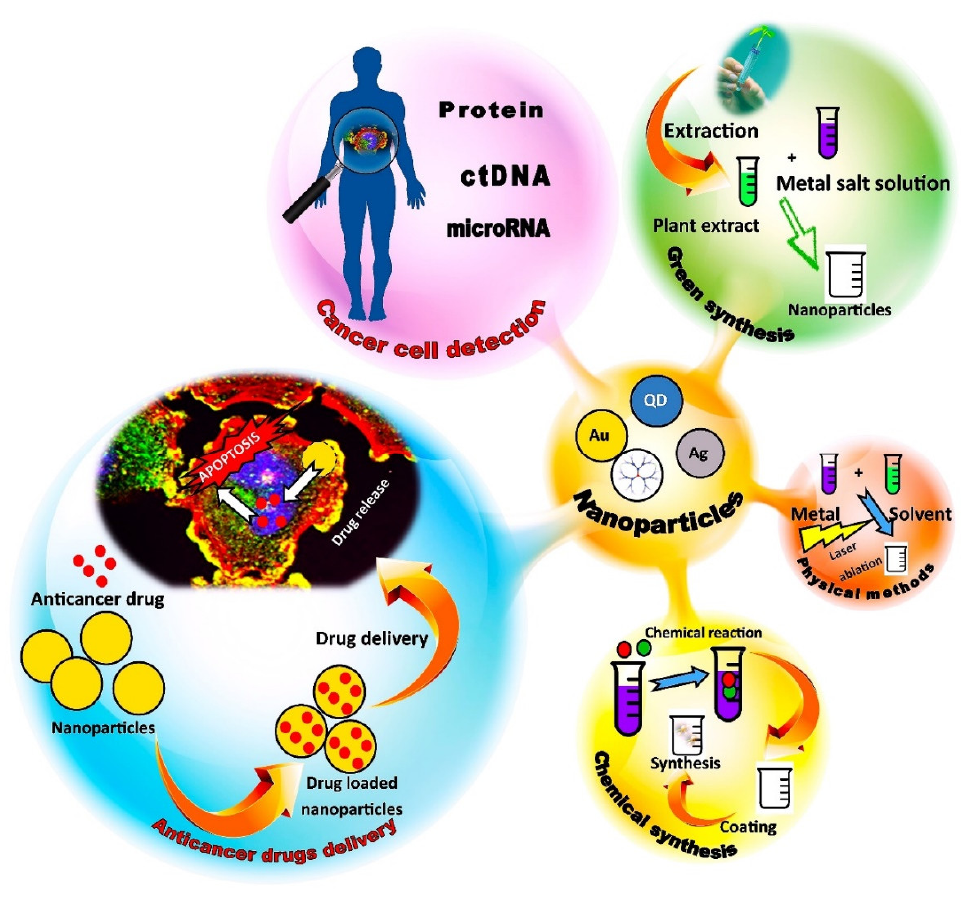
Figure 2. General scheme of the synthesis and application of nanoparticles in cancer diagnosis and treatment.